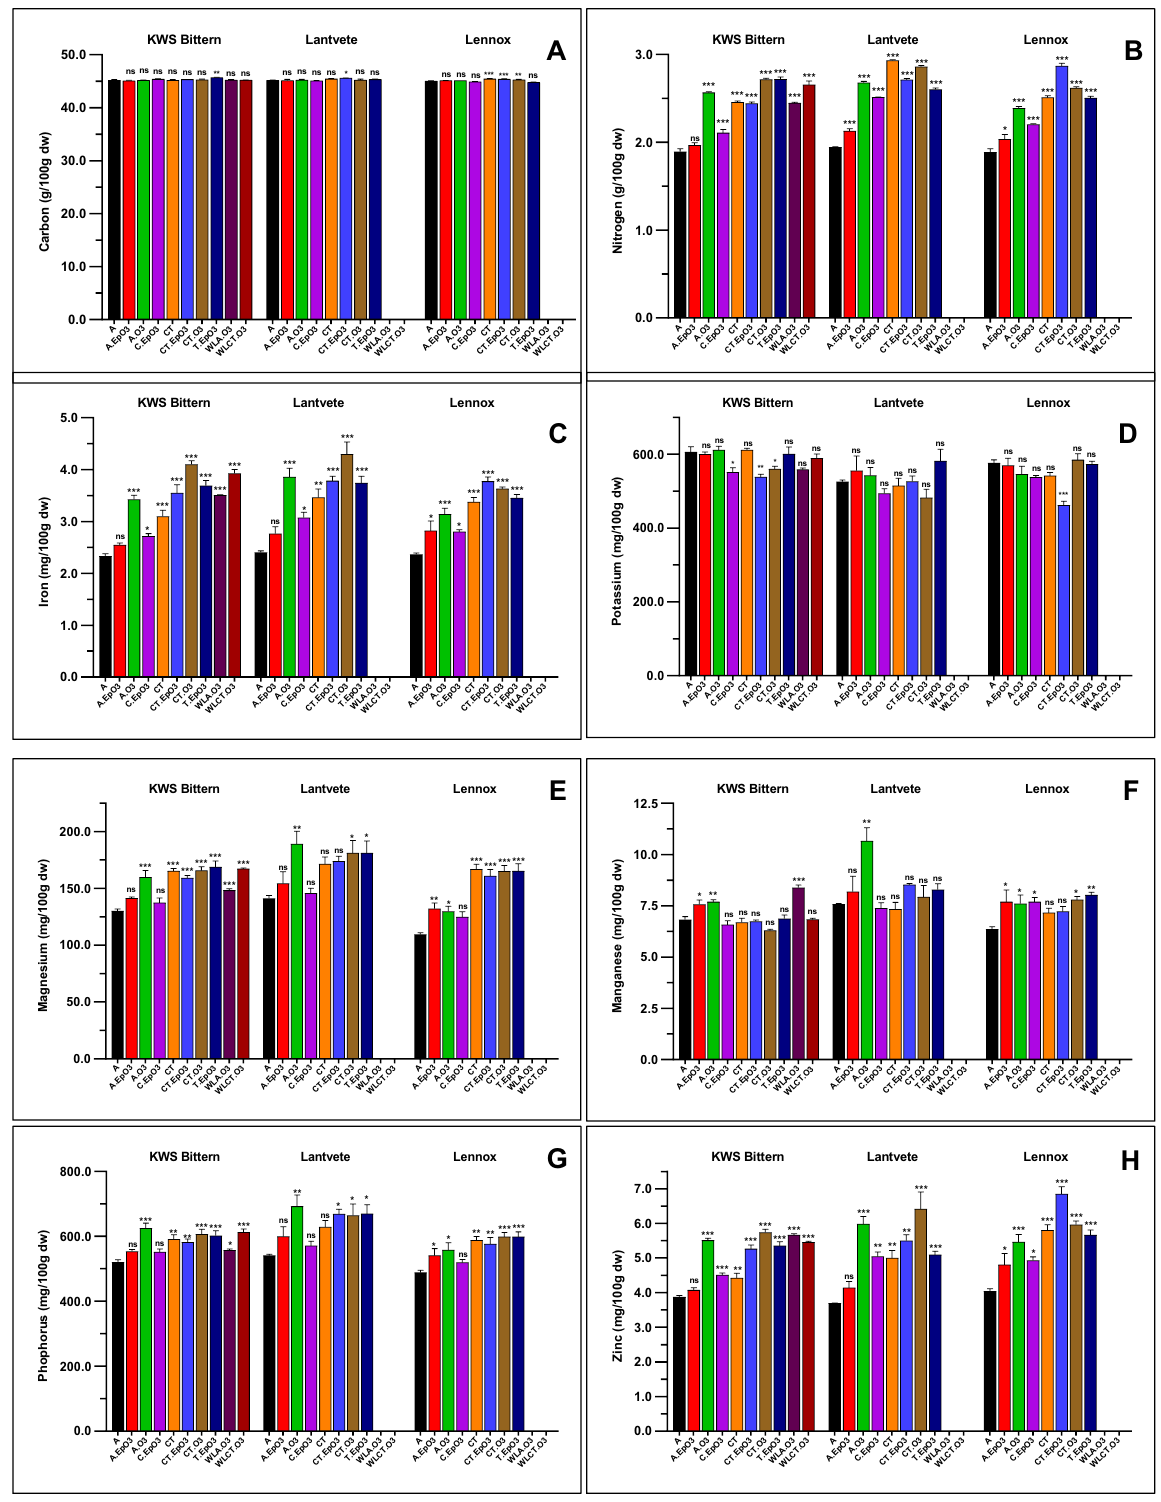
Figure 1. Effect of temperature, CO 2 , ozone and water availability on grain mineral content (carbon ( A ), nitrogen ( B ), iron ( C ), potassium ( D ), magnesium ( E ), manganese ( F ), phosphorus ( G ) and zinc ( H )) of three European wheat varieties. Treatments: A = Ambient CO2, lower temperature settings and no O3 addition (control). A.EpO3 = Ambient CO2, lower temperature settings and episodic O3 addition. A.O3 = Ambient CO2, lower temperature settings and chronic O3 addition. C.EpO3 = High CO2, lower temperature settings and episodic O3 addition. CT = High CO2, higher temperature settings, and no O3 addition. CT.EpO3 = High CO2, higher temperature settings and episodic O3 addition. CT.O3 = High CO2, higher temperature settings and chronic O3 addition. T.EpO3 = Ambient CO2, higher temperature and episodic O3 addition. WLA.O3: Ambient CO2, lower temperature settings and chronic O3 addition (i.e., A.O3), in water-limited condition. WLCT.O3 = High CO2, higher temperature settings and chronic O3 addition (i.e., CT.O3), in water-limited condition. ns, *, ** and *** mean non-significant, significant at 0.05, 0.01 and 0.001, respectively, Dunnett’s test with treatment A as